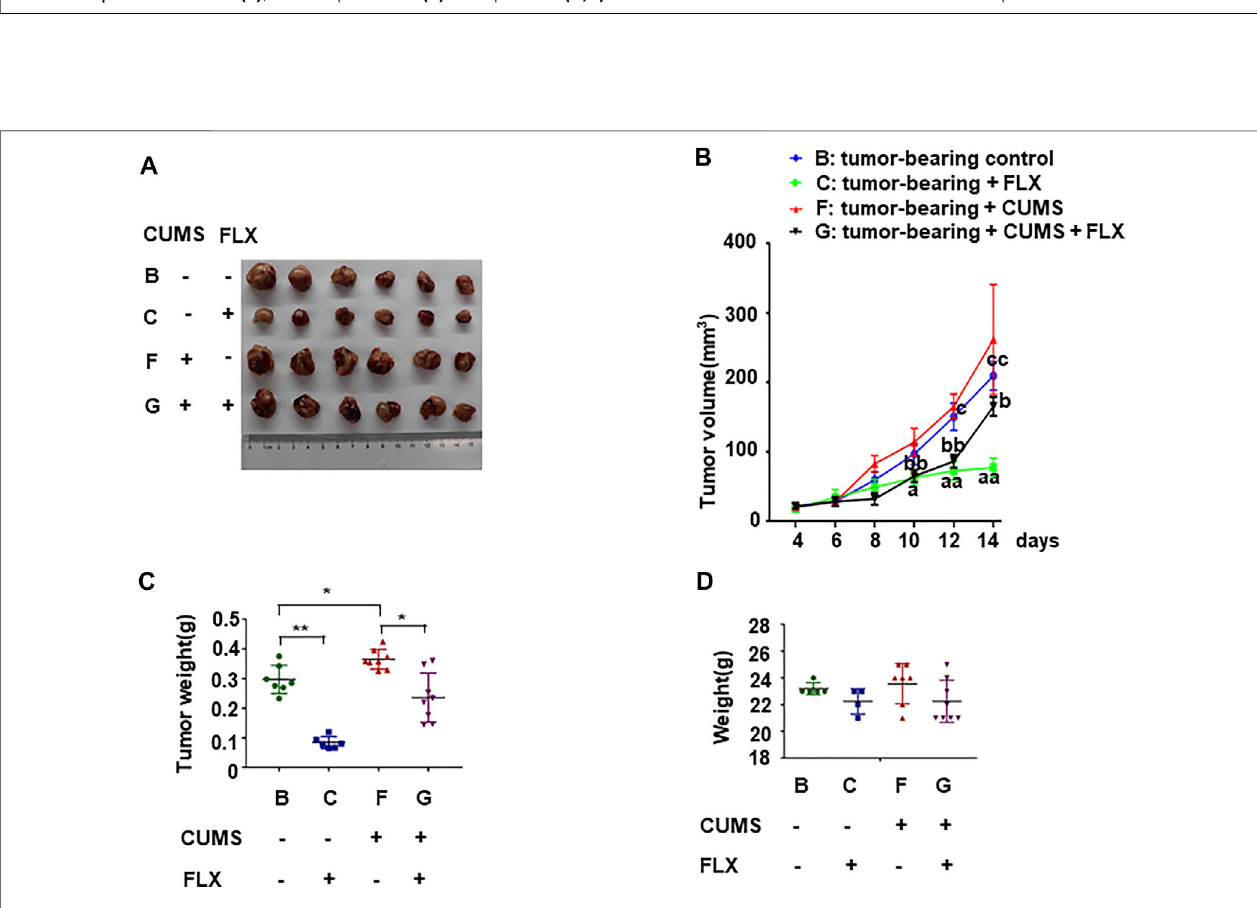
FIGURE 3 | Antitumor of fl uoxetine in tumor bearing mice. (A) Representative images of tumor tissues in different groups. (B,C) Volume and weights of tumor. (D) Weights of mice. Data were expressed as mean ± SD. * p < 0.05, ** p < 0.01; aa p < 0.01: tumor-bearing control vs. tumor-bearing + FLX; bb p < 0.01: tumor-bearing + CUMS vs. tumor-bearing + CUMS + FLX; c p < 0.05, cc p < 0.01: tumor-bearing control vs. tumor-bearing + CUMS.